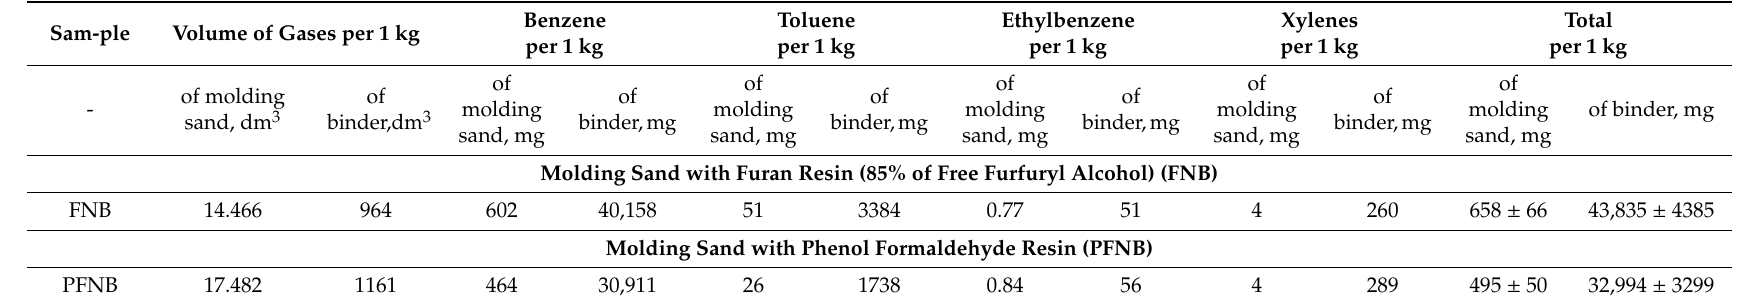
Table 3. Concentration of BTEX formed during thermal decomposition of molding sands FNB and